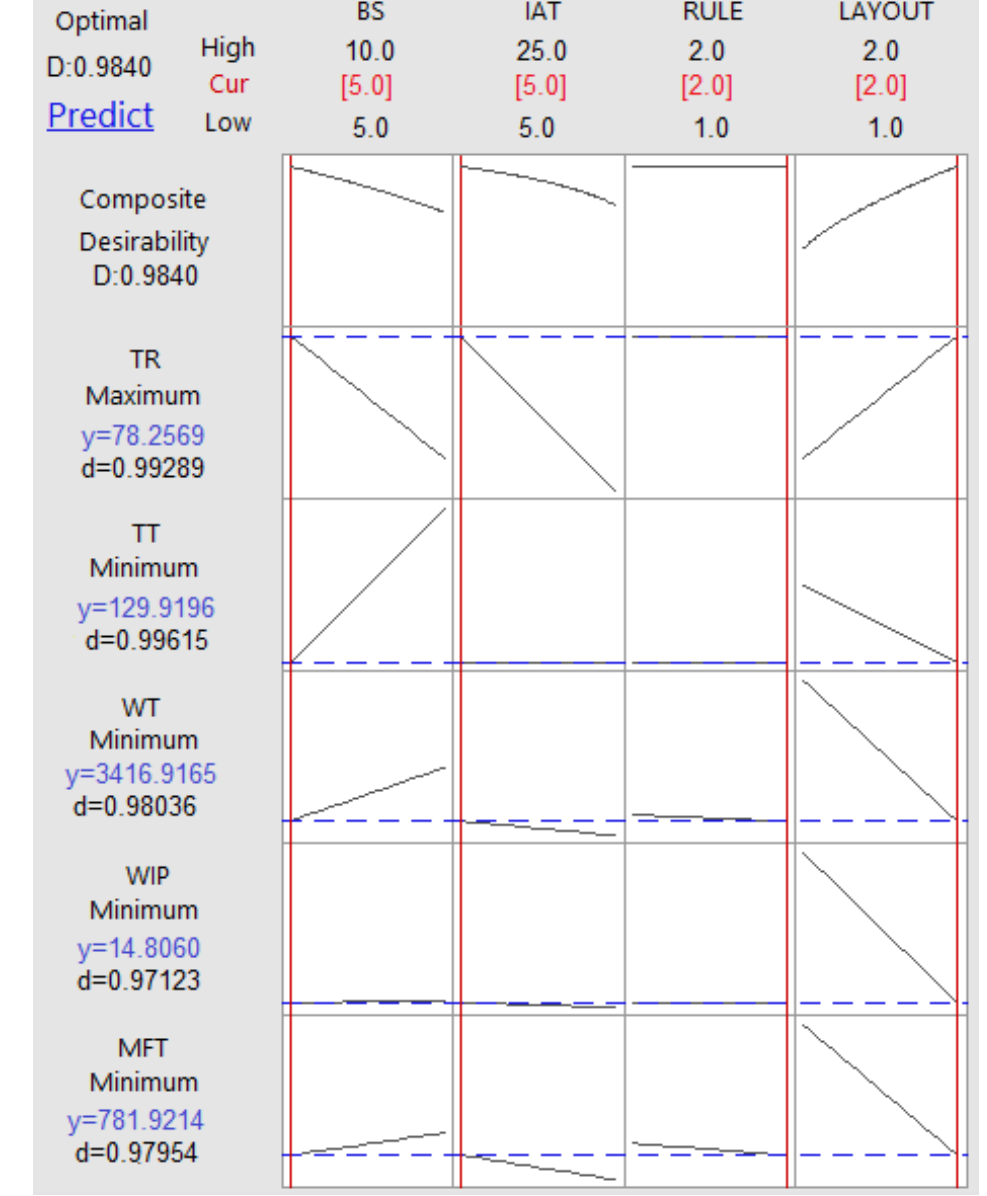
Figure 7. Desirability optimization results.